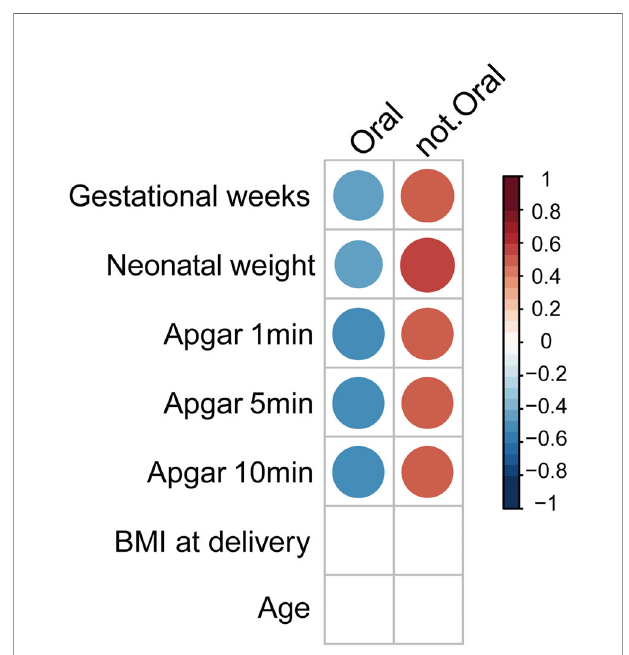
FIGURE 4 | Correlations of parameters and abundance of oral-to-gut bacteria. Coef fi cient of correlation between clinical features and total potential oral bacteria. The relationship between the relative abundance of oral and non-oral bacteria and host parameters (gestational weeks; neonatal weight; Apgar scores in 1, 5, and 10 min; BMI at